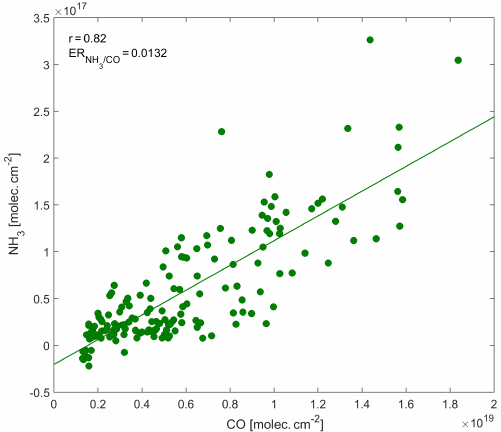
Figure 2. Example of linear regression between NH 3 and CO to- tal columns (moleccm − 2 ) for 2015 for one pixel of the selected grid box, corresponding to the evergreen broadleaf forest (EBF) biome in Indonesia (latitude = − 3 ◦ , longitude = 113 ◦ ). The corre- lation coefficient ( r ) and the ER NH ratio (slope of the linear 3 / CO regression) are given as an inset. The ordinary least square fit has been chosen here for the calculation of the regression